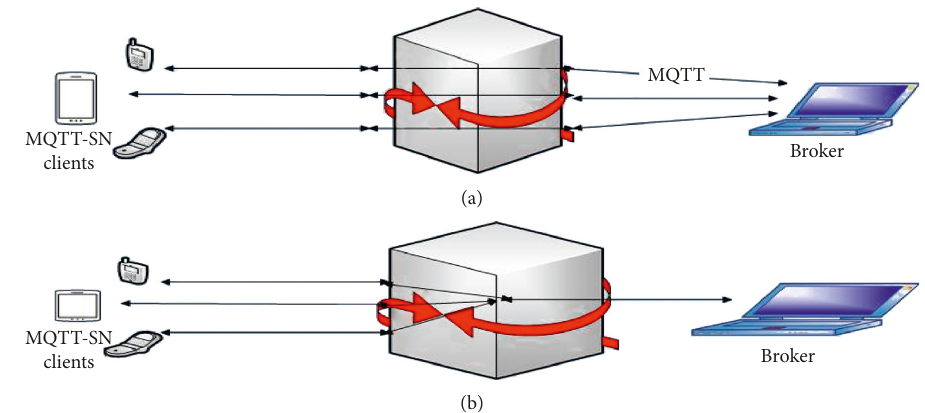
Figure 6: (a) Transparent gateway and (b) aggregating